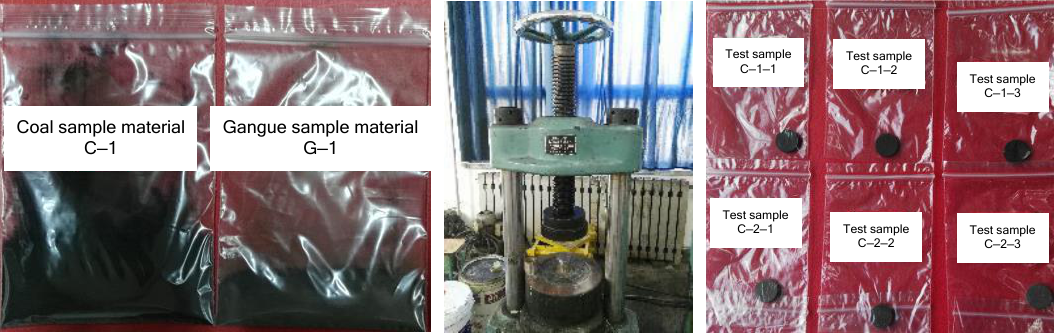
Figure 9. Preparation of coal and gangue samples for specific heat capacity test.